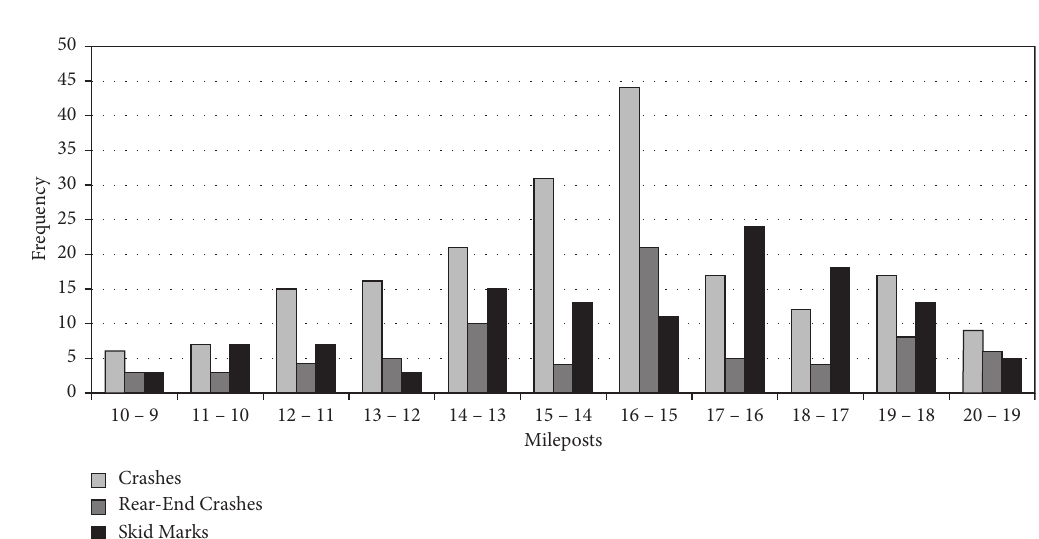
Figure 6: Number of crashes and skid marks on Interstate 80